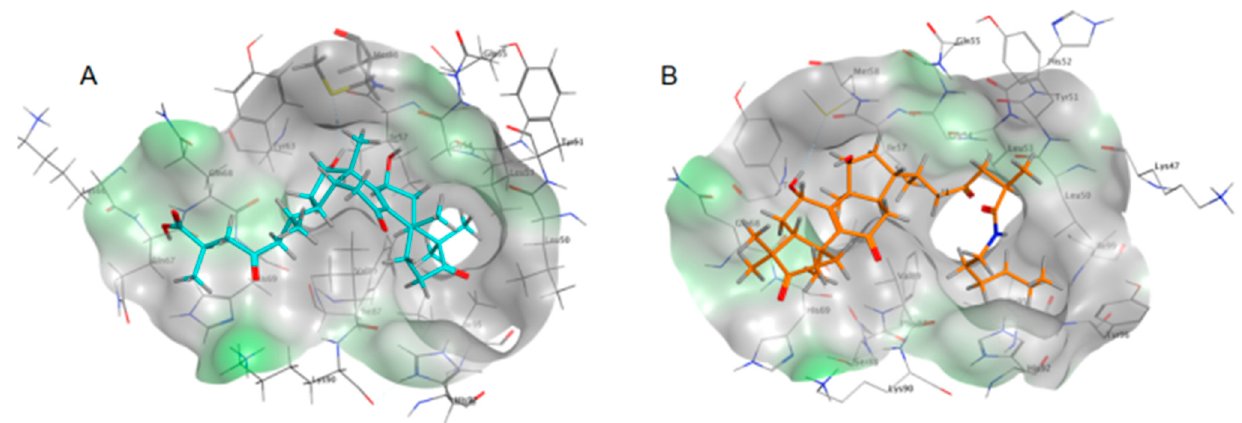
Figure 6. Molecular docking results of MDM2 (PBD ID: 4j3e) with GAA ( A ) and A2 ( B ). The pose of GAA in MDM2 is that the carboxyl term exposed to the solvent, the ring core is located in the pocket, and the hydroxyl-H has hydrogen bond interaction with Met58. The pose of A2 in MDM2 is opposite to that of GAA. The longer hydrophobic n -hexyl anchors into the pocket and has hydrophobic interaction with His92. The ring part faces out of the solvent and retains the interaction with Met58.